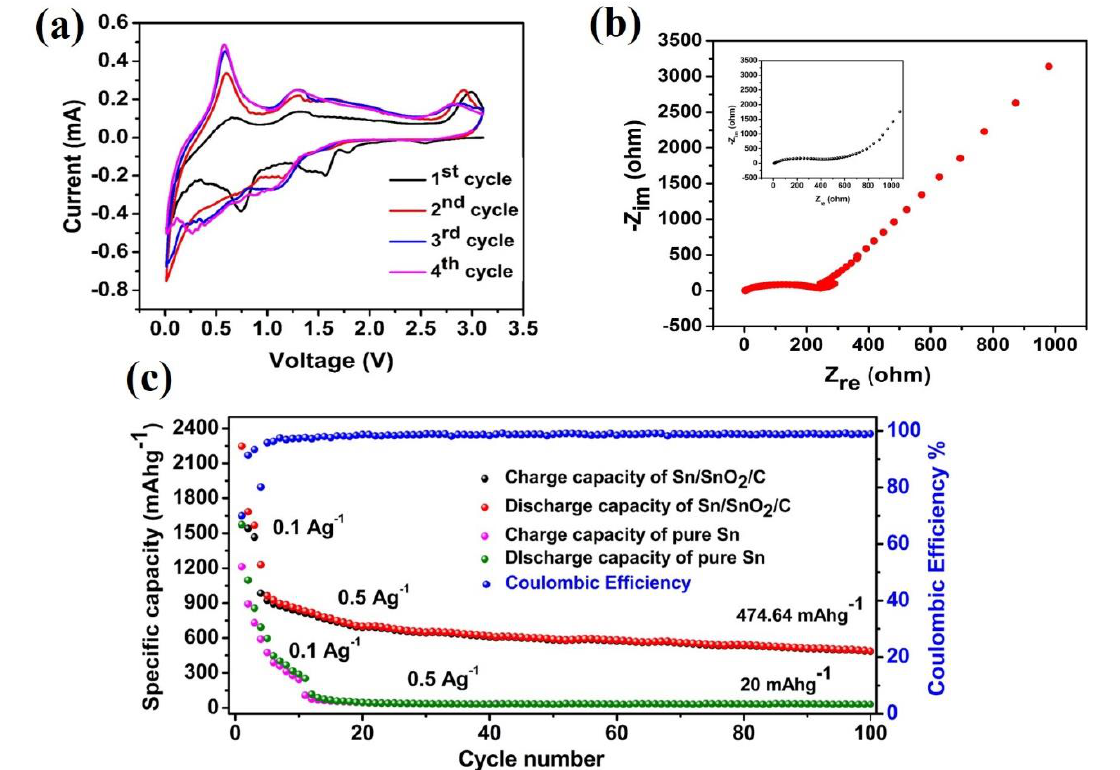
Figure 5. Electrochemical performance of Sn/SnO 2 /C nano-composite for LIBs: ( a ) initial five cyclic voltammetry curves scanned from 0.01 to 3 V at a rate of 0.01 mV s −1 ; ( b ) EIS of Sn/SnO 2 /C nano ─ composite; and ( c ) cycle performance of Sn/C electrode acquired at two different current densities of about 100 mA g −1 and 500 mAg −1 .